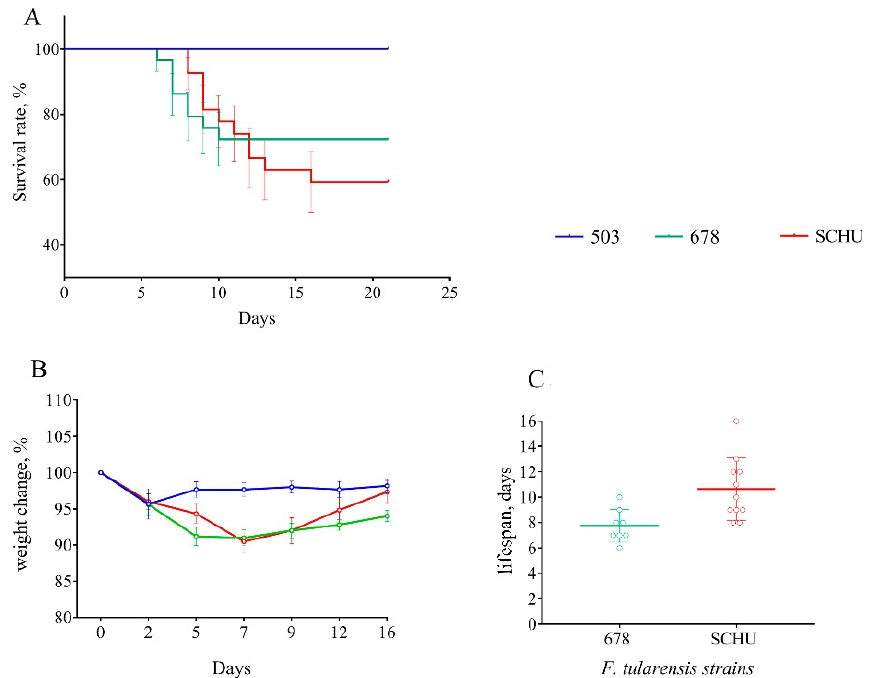
Figure 2. Survival rate ( A ), bodyweight changes ( B ), and lifespan ( C ) of mice immunized 60 days before infection with virulent strains of F. tularensis : subsp. holarctica 503, subsp. mediasiatica 678, and subsp. tularensis SCHU. Values are indicated with the standard error of the mean (SEM) for each measurement point.